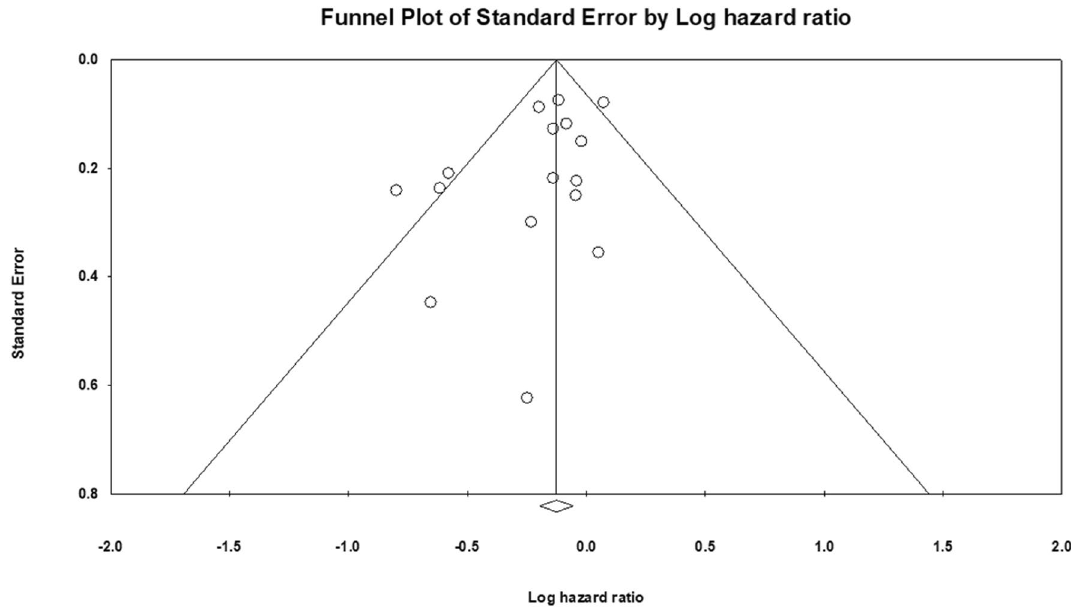
Fig. 3 Funnel plot standard error by log hazard ratio: heterogeneity: df summary added as a Additional file 1: Table